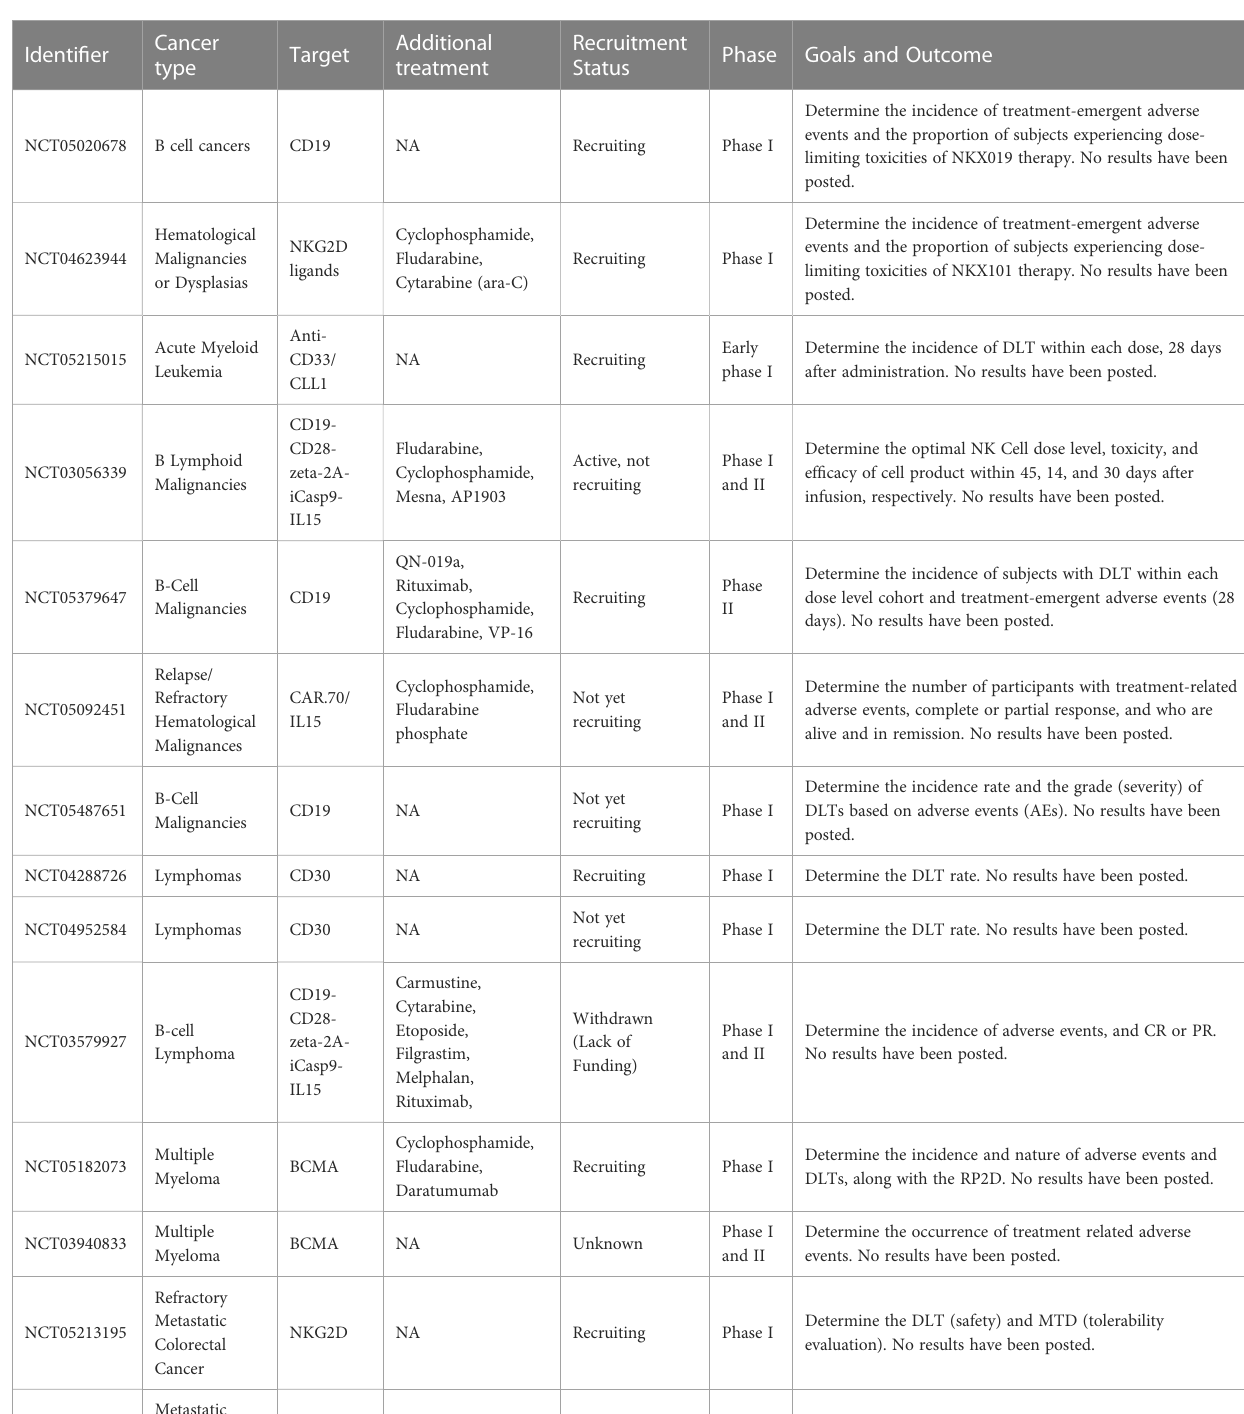
TABLE 5 Current CAR-NK cells clinical